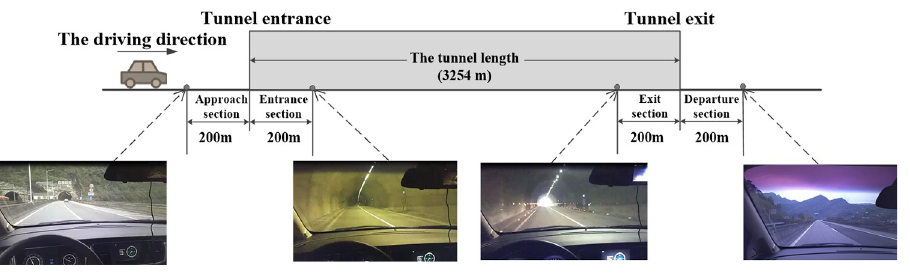
Fig 1. The tunnel section division.